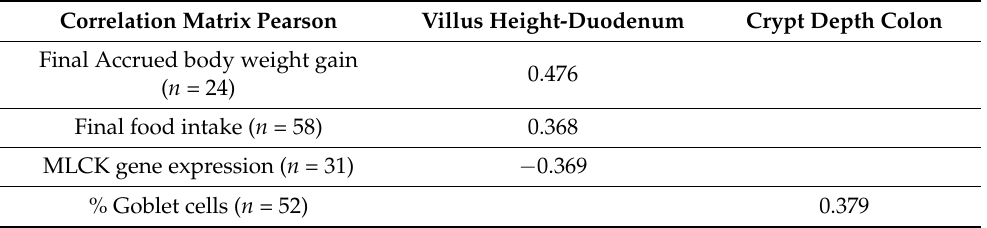
Table 8. Pearson correlation coefficients of intestine parameters in Wistar rats. Correlation Matrix